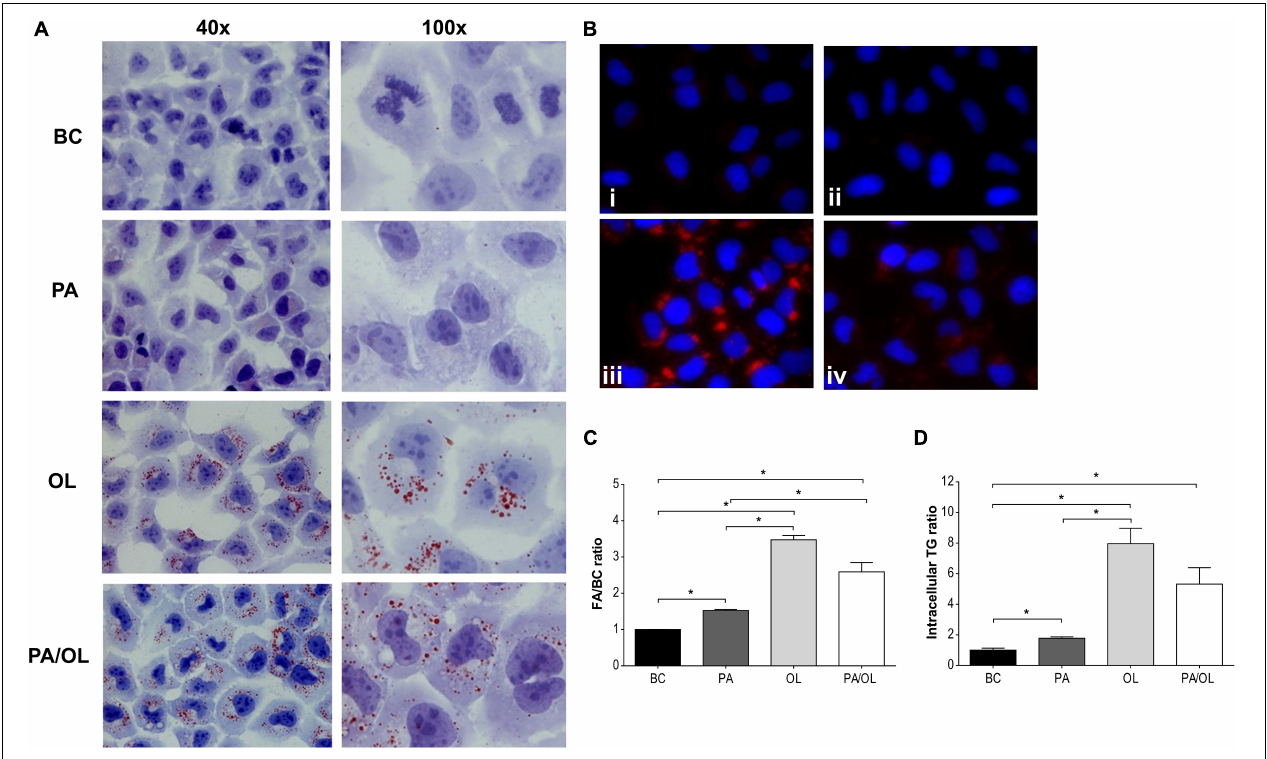
FIGURE 5 | Analysis of lipid droplet formation. (A) Images (400 × ) obtained by optical microscopy with Oil Red O dye and (B) by fluorescence microscopy with the LD540 stain, following incubations with the following fatty acid (FA) test solutions (without FBS): (i) BC, (ii) PA, (iii) OL, and (iv) PA/OL. (C) Quantification by flow cytometry of the LD540 signal. (D) Triglyceride intracellular levels. All data were obtained from three independent experiments, expressed as mean ratio in relation to BC ± deviation standard; * p < 0.05. BC = basal condition; PA = palmitic acid; OL = oleic acid; TG = triglyceride; FBS = fetal bovine